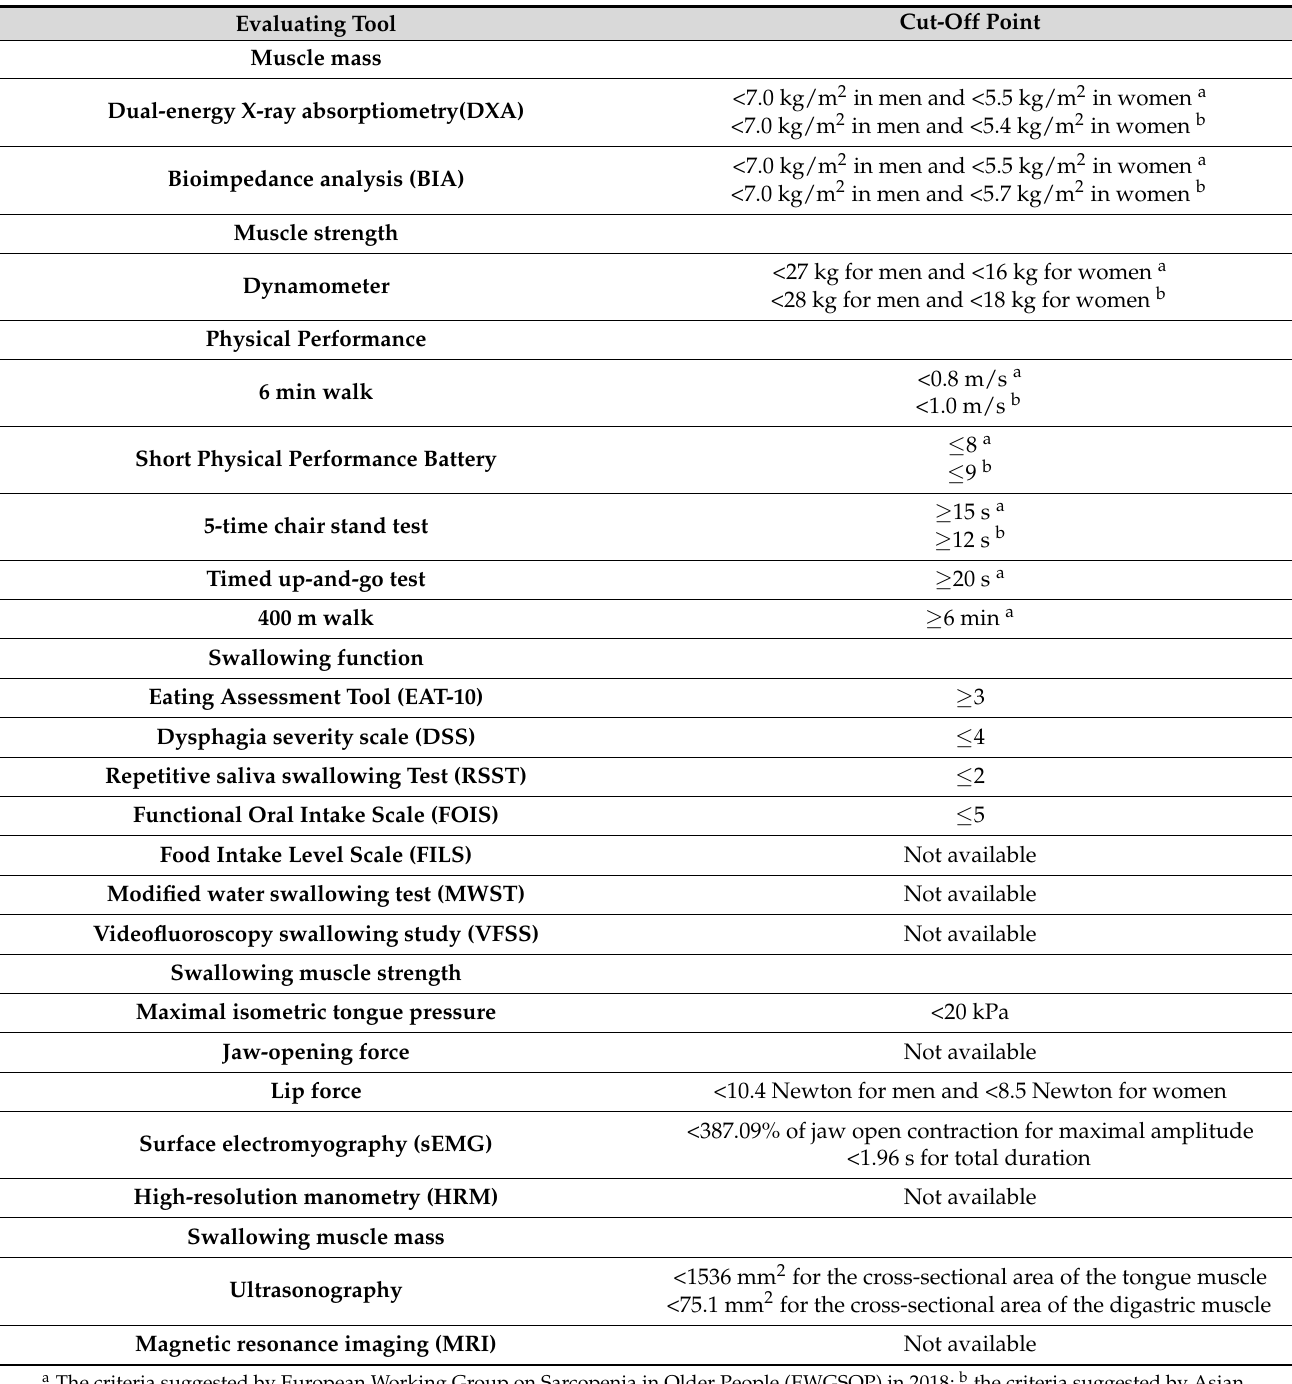
Table 3. The cut-off point of the tools for the diagnosis of sarcopenic dysphagia from the available literature. Evaluating